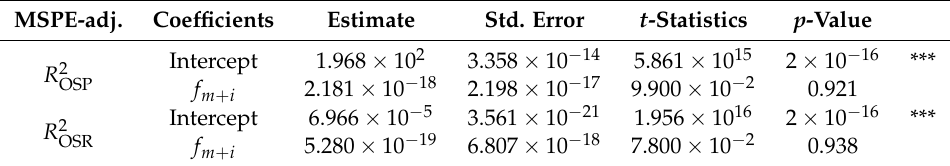
Table 3. The mean squared predictive error adjusted test, MSPE-adj, for R 2